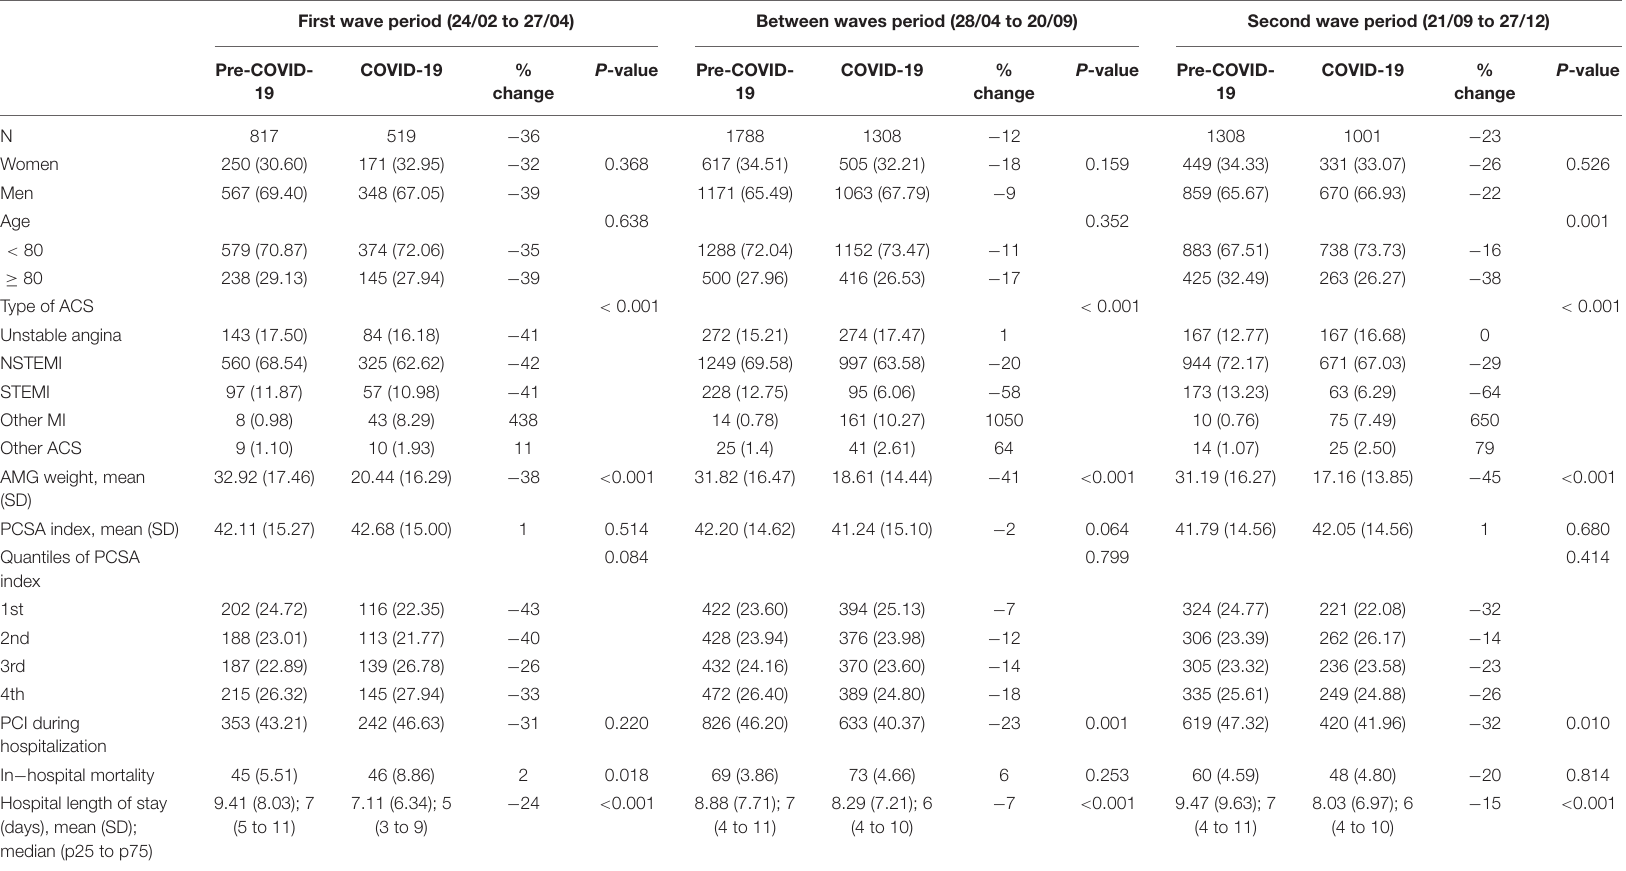
TABLE 1 | Characteristics of patients admitted to hospital for acute coronary syndrome (ACS) in each period compared with the reference pre-COVID-19